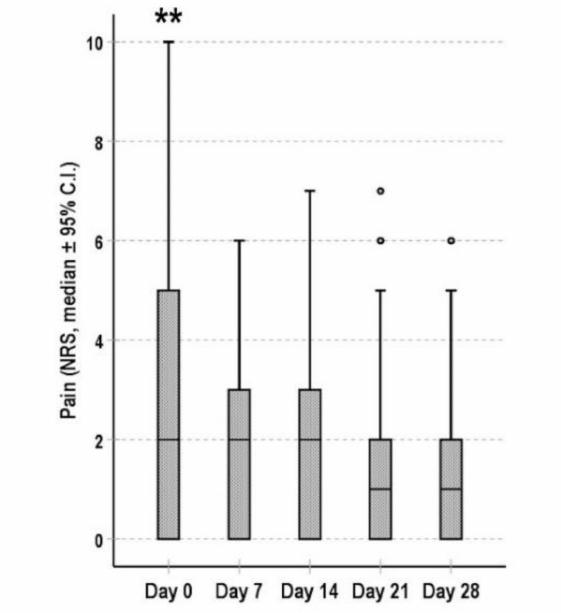
Figure 4. Evolution of pain during the 4 weeks of follow-up. Data are shown as the median (95% C.I.) of the NRS score. ** p < 0.001 for the comparisons between values at day 0 and values at day 7, 14, 21 and